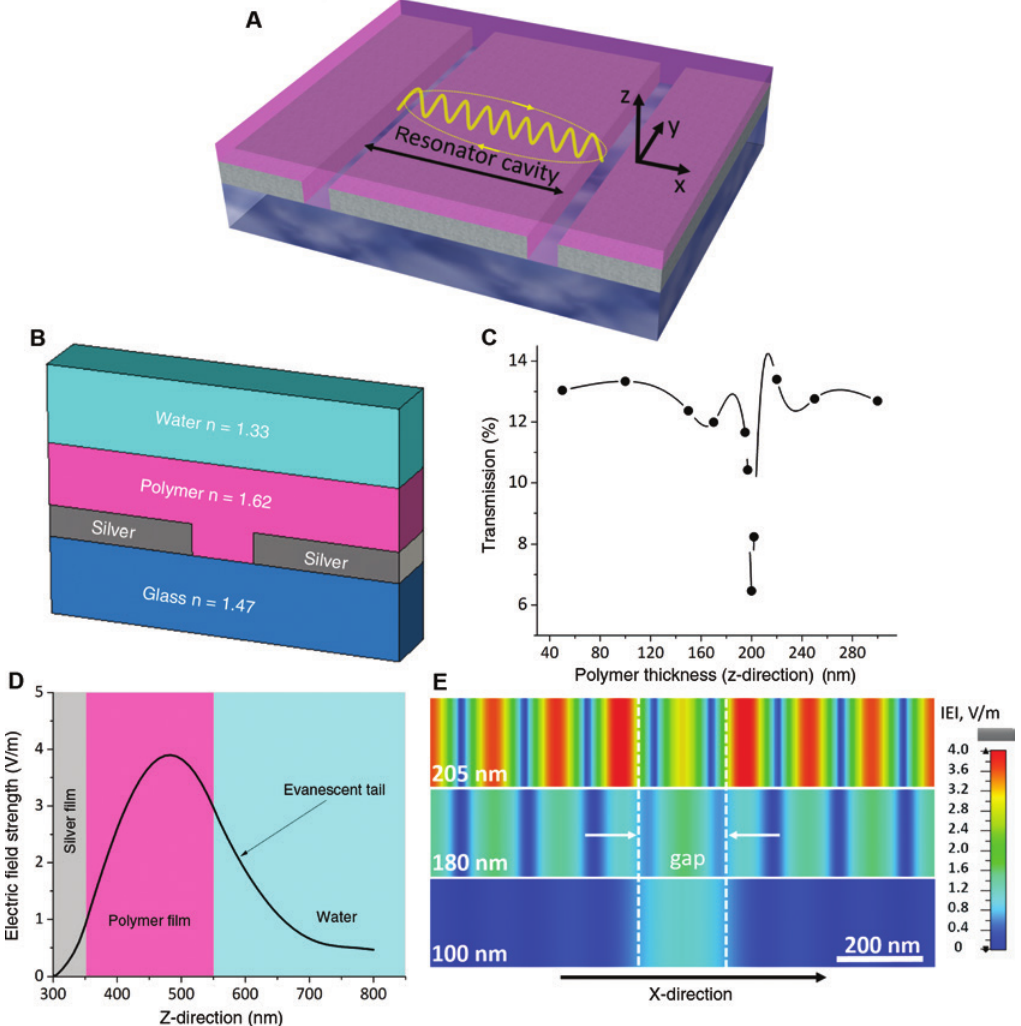
Figure 2: Simulation of thin film